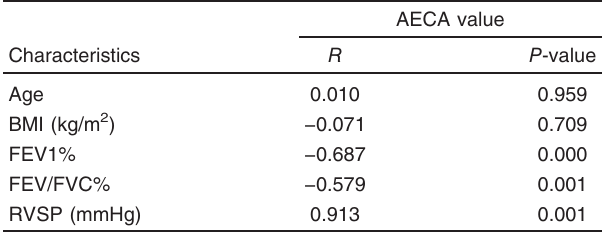
Table 2 Correlation of the COPD patients ’ antiendothelial cell antibodies and age, BMI, spirometry FEV1, FEV1/FVC ratio and RVSP